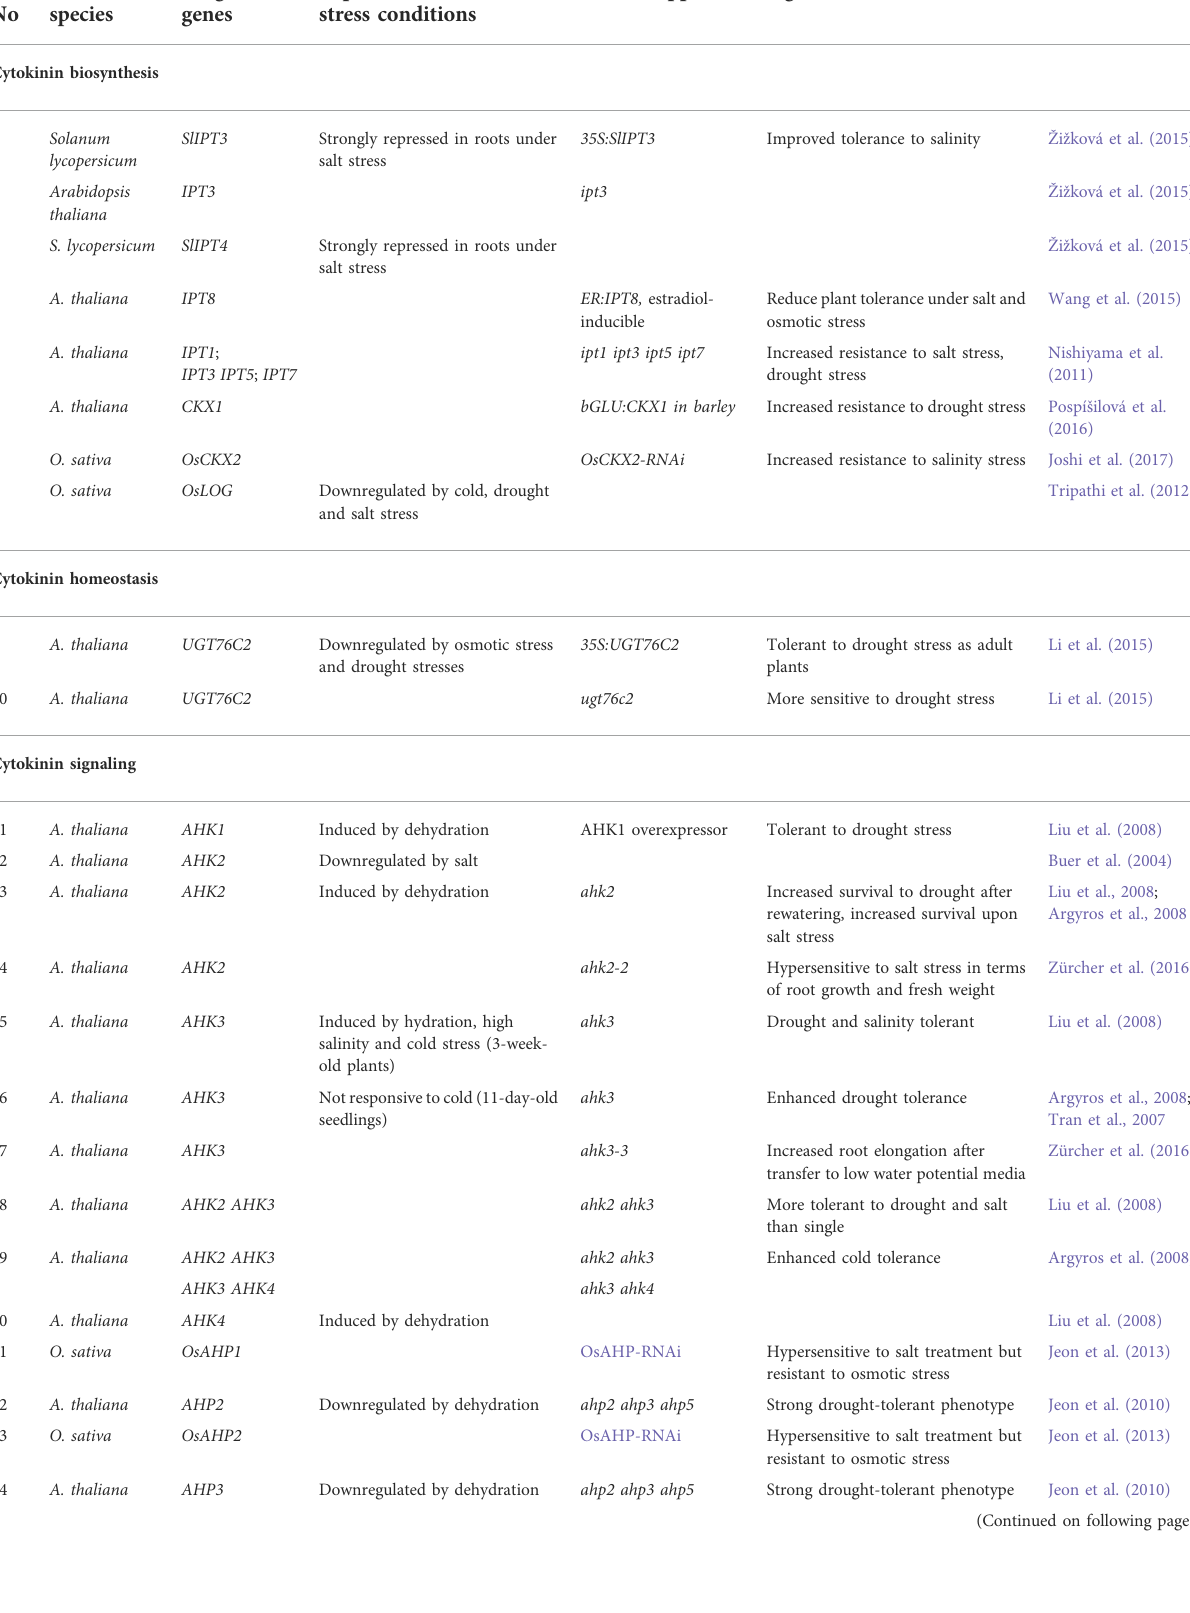
TABLE 1 A summary of genetic research aimed at elucidating the function of cytokinin in the response to abiotic